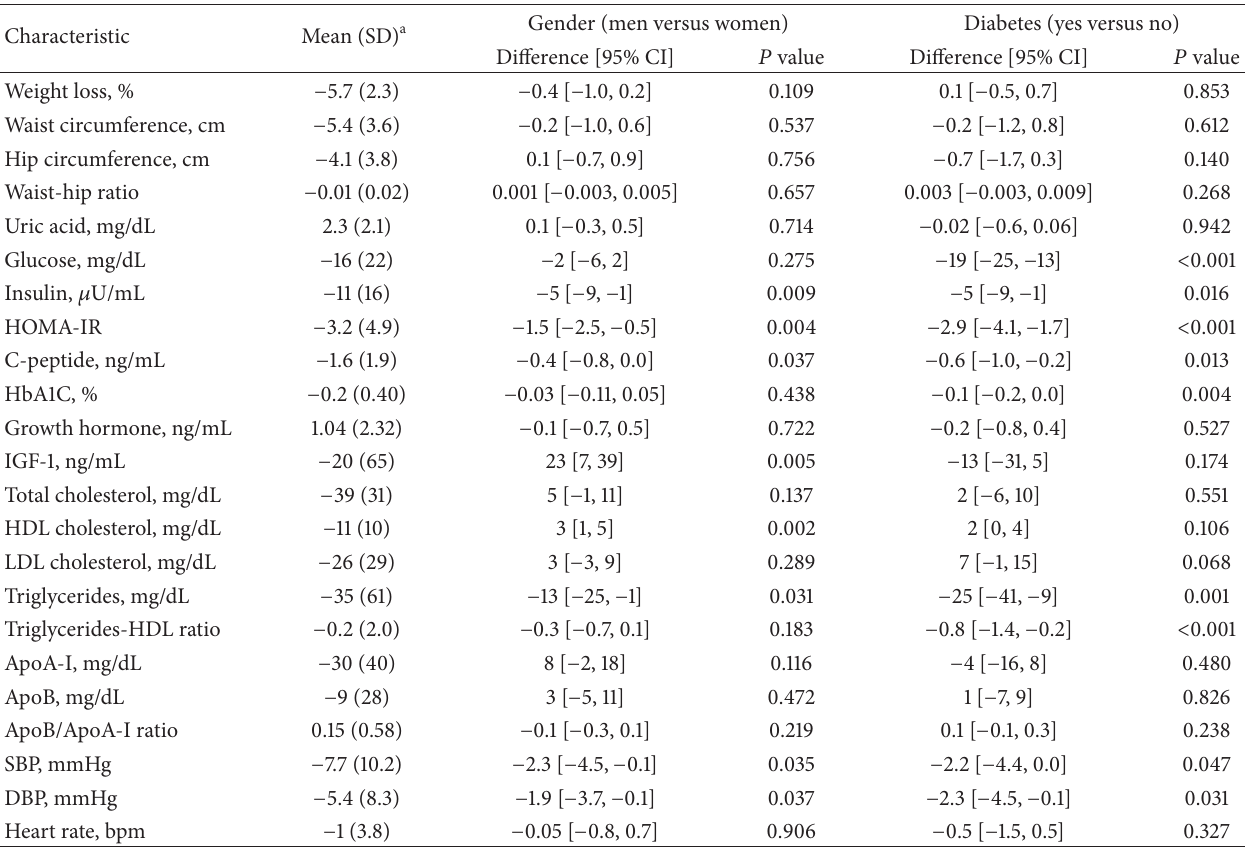
Table 5: Age-adjusted changes a in cardiometabolic and clinical parameters according to gender and diabetes (generalized linear regression analysis in intention-to-treat population [𝑁 = 364]